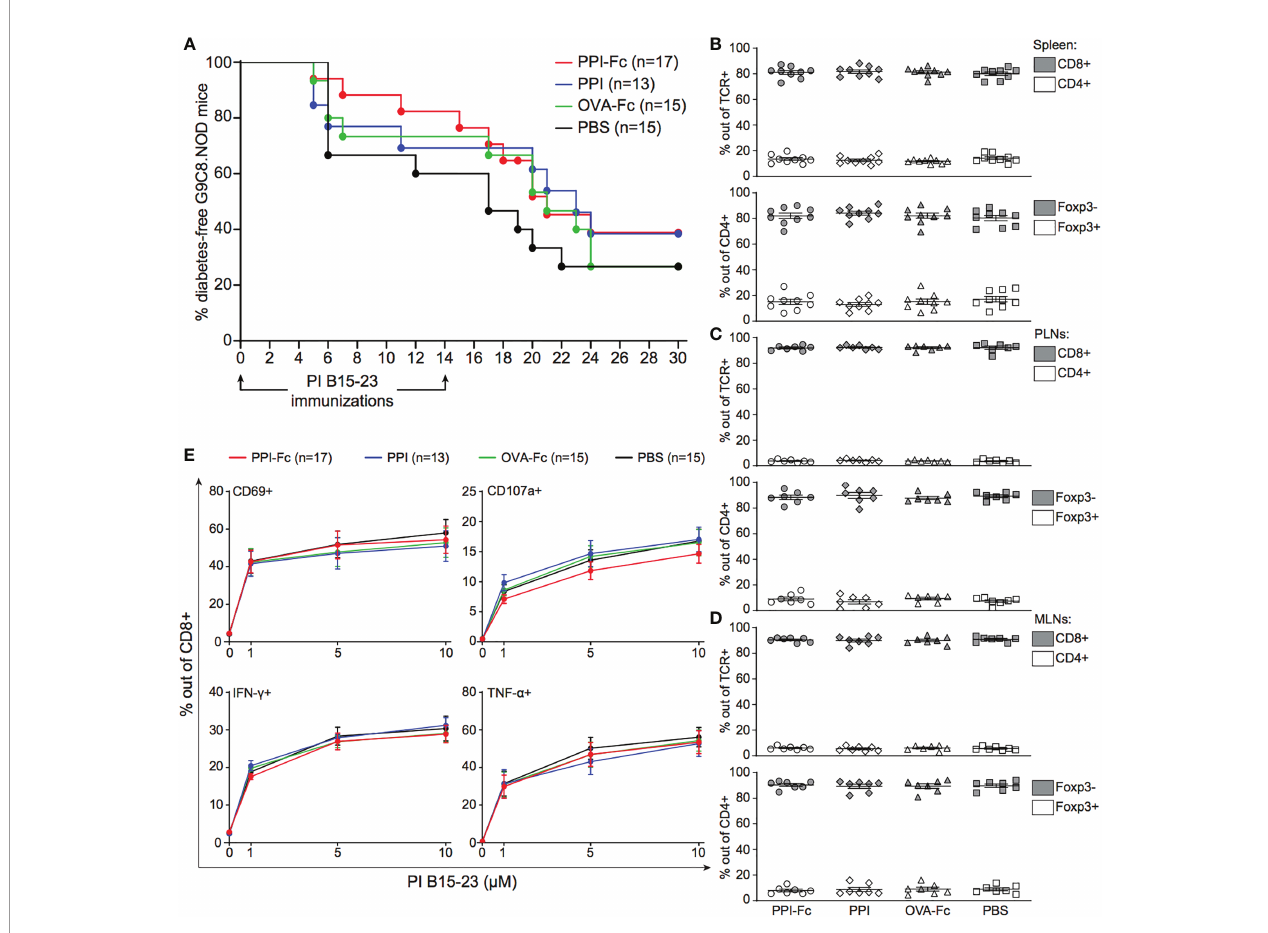
FIGURE 1 | Oral PPI-Fc does not prevent diabetes in TCR-transgenic G9C8.NOD mice. (A) Diabetes incidence in G9C8.NOD mice force-fed at day 1 with 50 µg PPI-Fc (red) or equimolar amounts of PPI (blue), OVA-Fc (green) or PBS (black). Diabetes was induced by prime-boost immunization with PI B15 – 23 peptide and CpG at 4 and 6 weeks of age. (B – E) Proportion of CD8 + and CD4 + T cells out of total TCR + cells (top panels) and of Foxp3 ‒ and Foxp3 + T cells out of total CD4 + T cells (bottom panels) in the spleen (B) , PLNs (C) and MLNs (D) of 4-week-old PPI-Fc- or control-treated G9C8.NOD mice. (E) Splenocytes from 4-week-old PPI-Fc- or control-treated G9C8.NOD mice were stimulated in vitro with increasing concentrations of PPI B15-23 peptide for 5 h and assessed for surface CD69 and CD107a expression and production of IFN- g and TNF- a . Results are from 4-5 separate experiments with 7-9 mice/group; bars indicate mean ± SEM